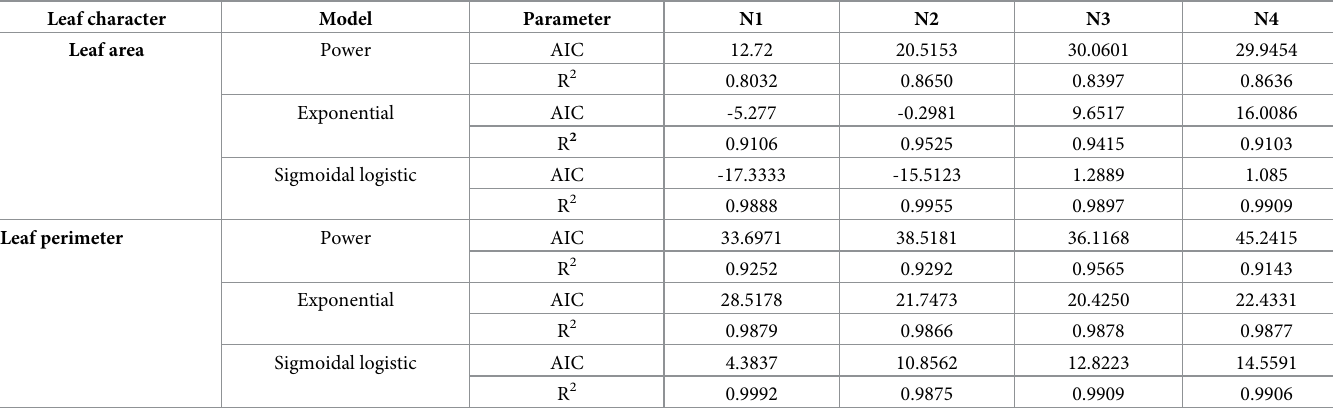
Table 3. Growth model fitted leaf area and perimeter data from of N treatments with and R 2 and AIC values. Leaf